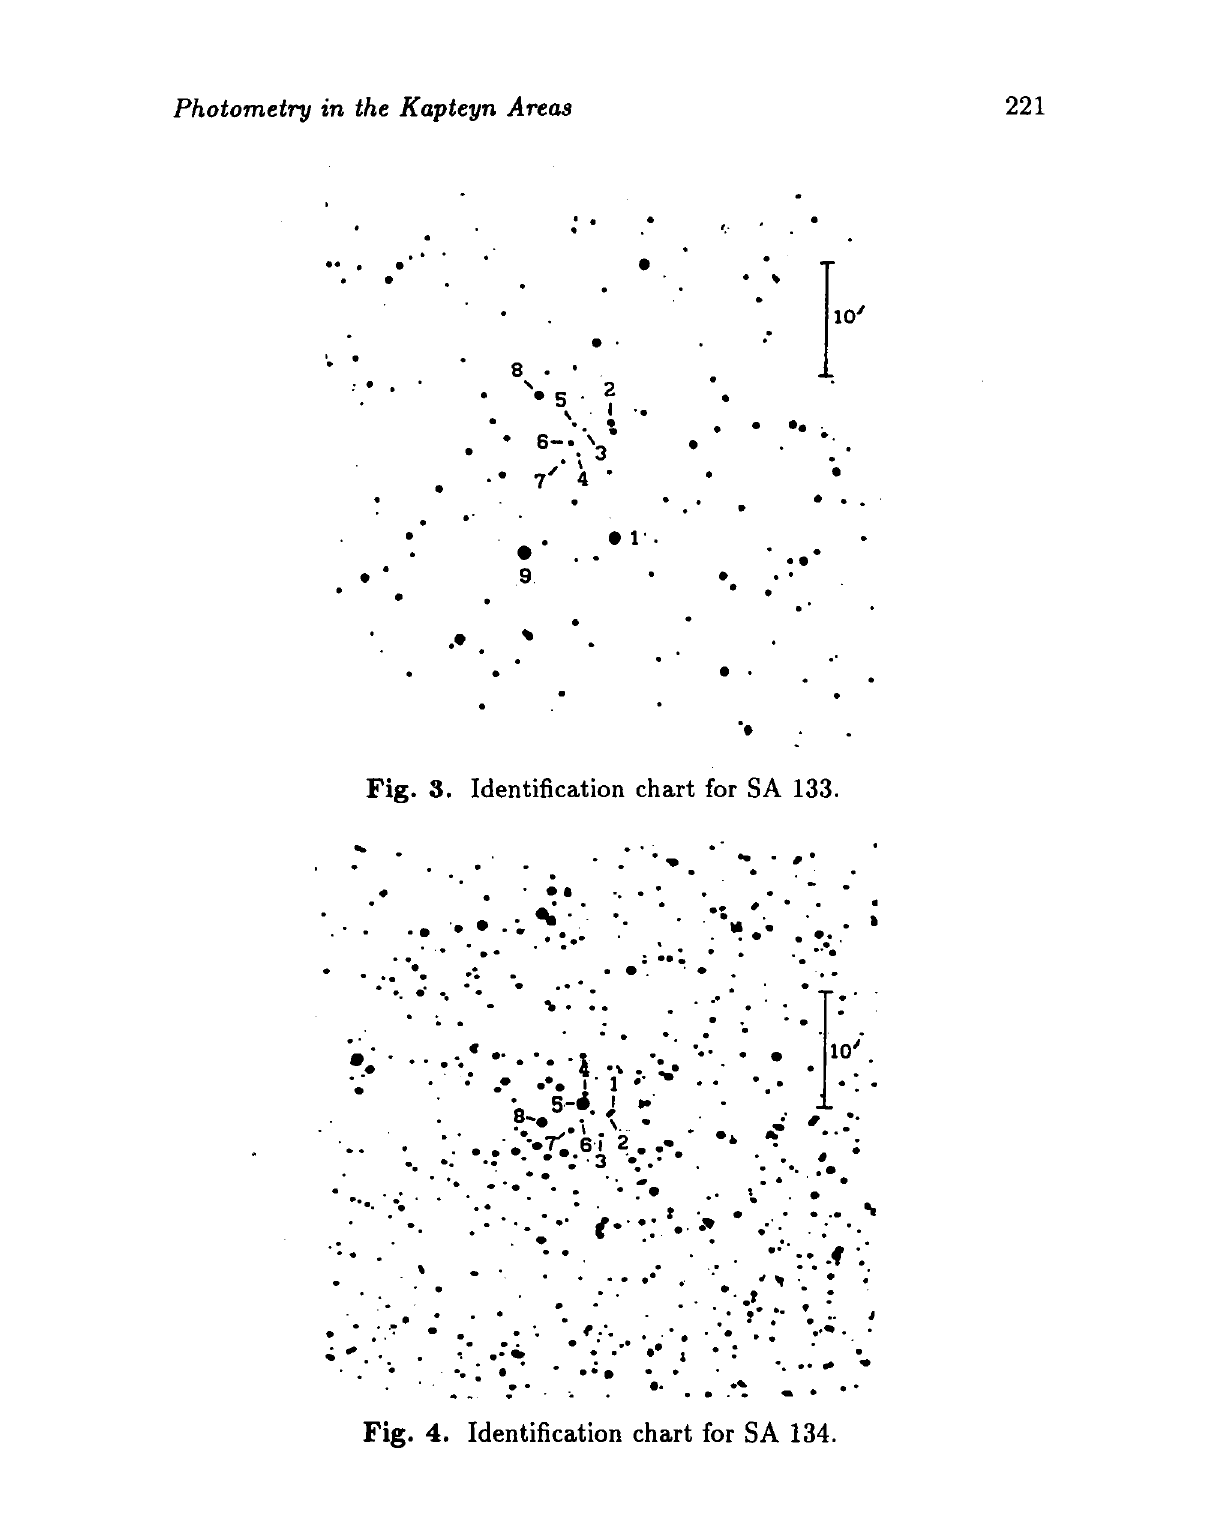
Fig. 4. Identification chart for SA